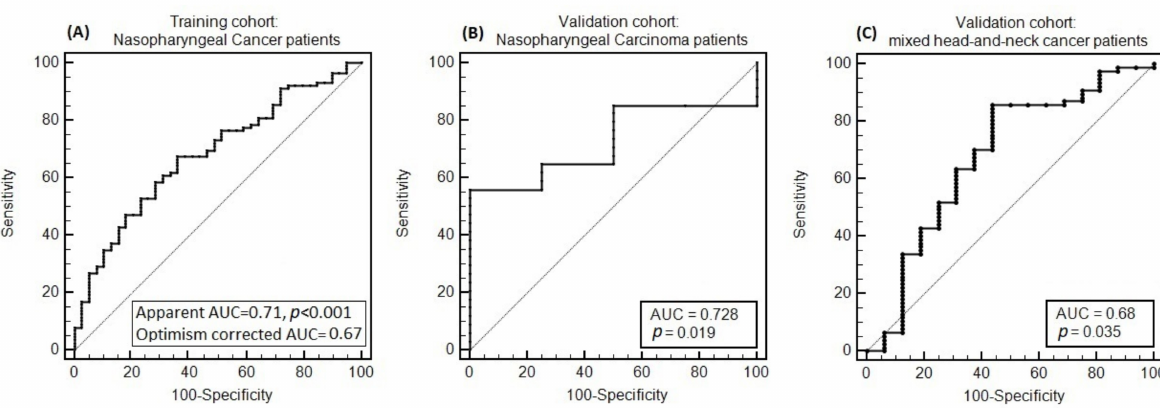
Figure 2. The receiver operating characteristic (ROC) curve for the model for grade ≥ 2 acute salivary dysfunction as applied in the three cohorts considered in this study: ( A ) nasopharyngeal cancer (NPC) cohort use for model development, ( B ) NPC validation cohort and ( C ) head and neck cancer other than NPC validation cohort